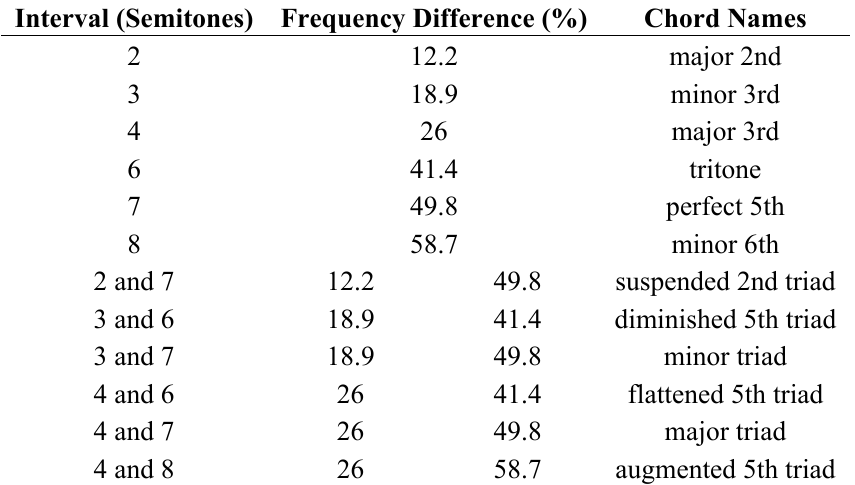
Table 2. Intervals used in this study showing their frequency differences and common music names.